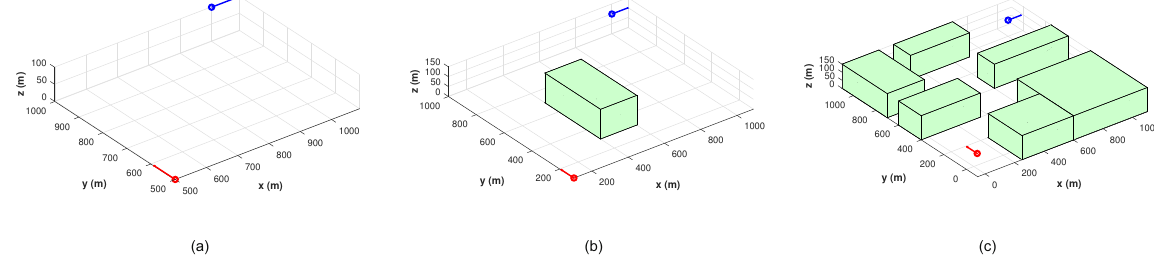
Figure 8. Simulation environment: ( a ) No obstacles. ( b ) Centered obstacle. ( c ) Scattered obstacles. The states of the position and direction of each obstacle case are shown in Table 1.